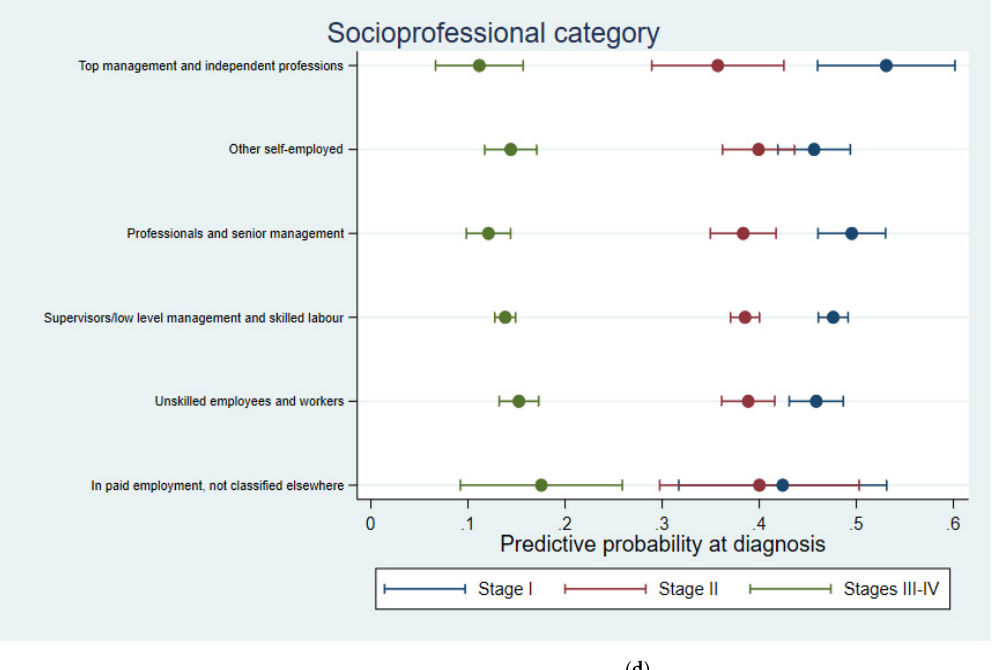
Predicted probability at diagnosis: for each occupational factor, this corresponds to the model-predicted probabilities adjusted on all other factors in the model. Figure 3. Predictive probability of being diagnosed with breast cancer of stage I, II or III–IV by ( a ) occupation, ( b ) skill level required for the occupation, ( c ) economic activity branch and ( d ) socioprofessional category adjusted for age, calendar time, canton, marital status and nationality for females in western Switzerland, 1990–2014.